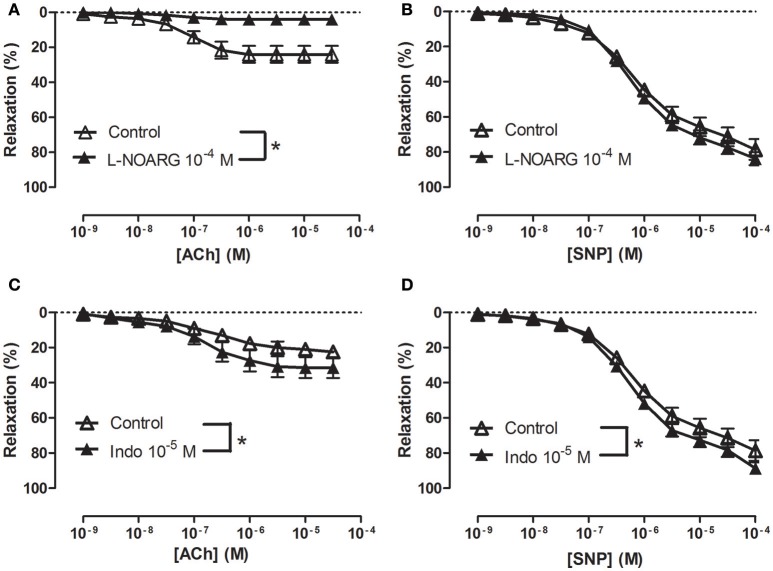
Involvement of nitric oxide (NO) in acetycholine (ACh) relaxation of rat corpus cavernosum. Concentration-response curves for (A,C) ACh (n = 7,10) and (B,D) sodium nitroprusside (SNP) (n = 7) in the absence and the presence of (A,B) an inhibitor of NO synthase, L-nitro-arginine (L-NOARG, 100 μM) (n = 10,7) or (C,D) cyclooxygenase, indomethacin (10 μM) (n = 7,7). Data are expressed as means ± S.E.M. *P ≤ 0.05, curves were significantly different, two-way ANOVA followed by a Bonferroni's post-test.